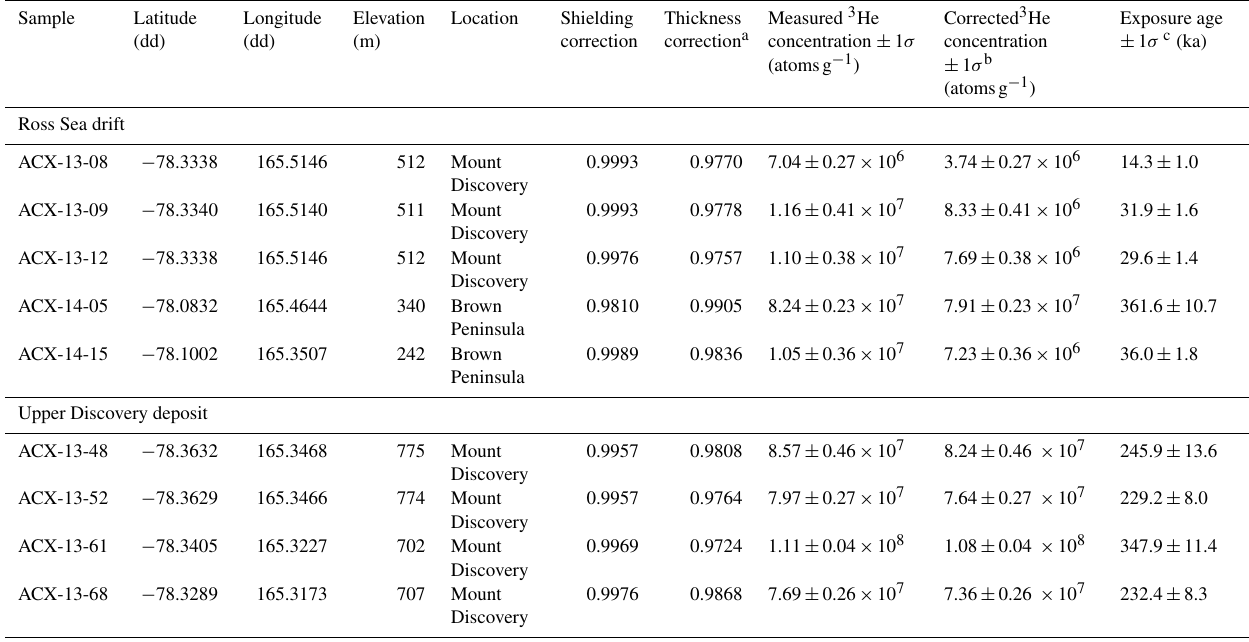
Table 1. 3 He pyx exposure age from Ferrar Dolerite.